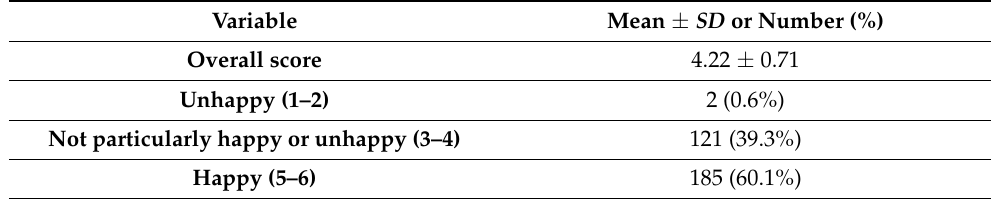
Table 2. Oxford Happiness Questionnaire.